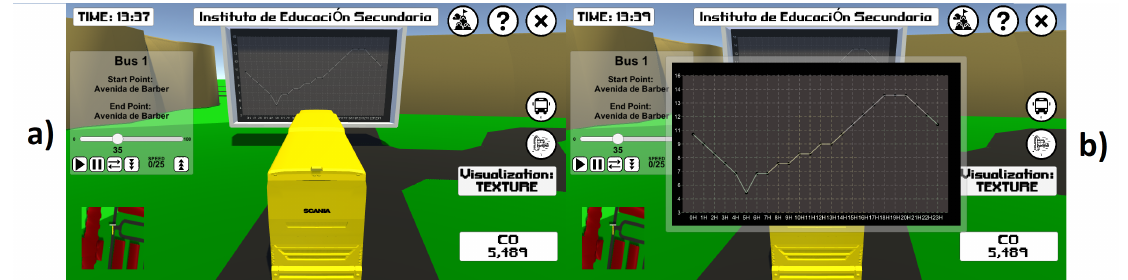
Figure 5. Billboard with pollution data evolution. The evolution of the pollutant’s concentration throughout the day is plotted on a billboard that shows up where the user clicks on the terrain ( a ). The billboard always faces the user, and its contents are zoomed in when user clicks on it ( b ).